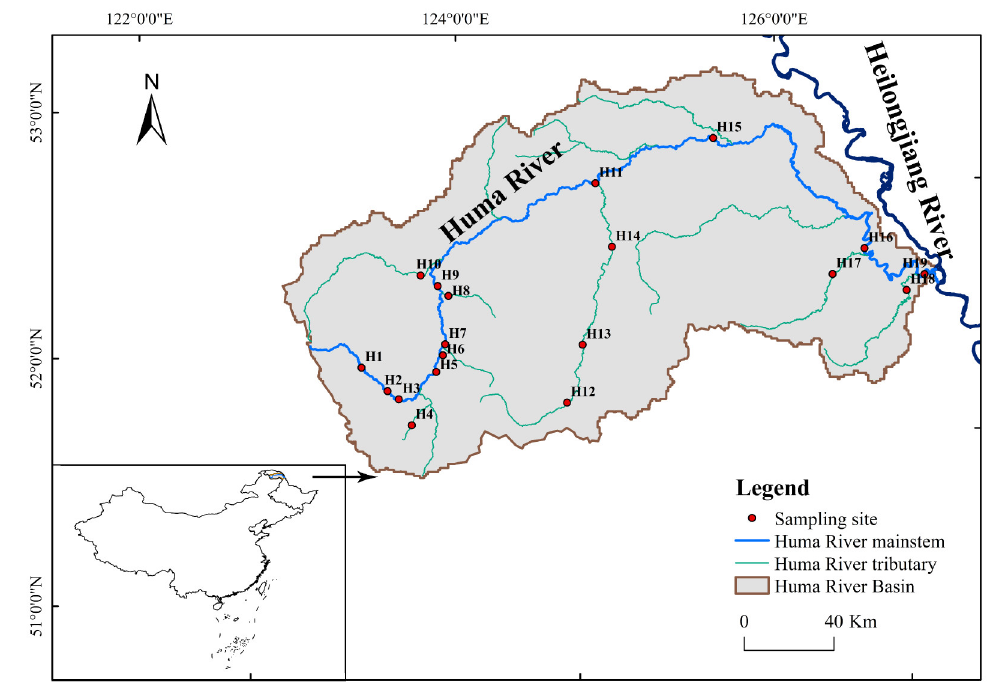
Figure 1. Study area with sampling sites in the Huma River Basin, China.